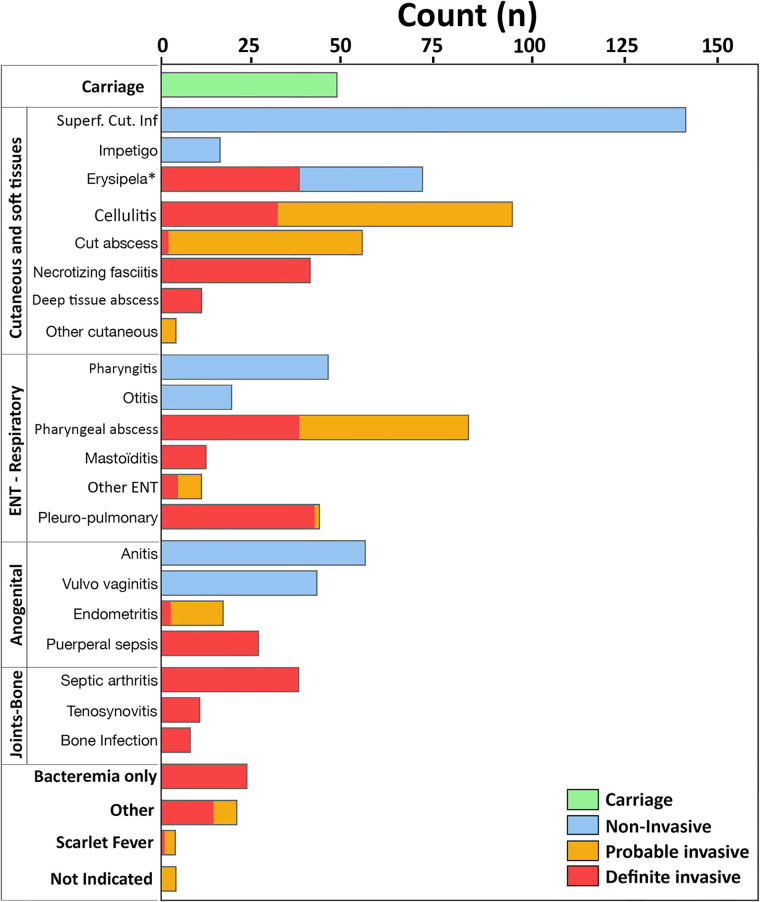
Clinical diagnosis of GAS infections.Infection diagnoses were organised according to their main location. For each diagnosis, invasiveness categories (“Carriage”, “Non-invasive”, “Probable invasive”, and “Definite invasive”) were indicated by colours (see the legend at the bottom right). *Cases reported as erysipelas were considered as definite invasive infections when blood cultures were positive. The clinical presentations identified as “Other cutaneous” included chronic eschars (n = 3) and cutaneous fistula (n = 1); “Other ENT” included periorbital cellulitis (n = 4), ethmoiditis (n = 2), ocular non-invasive infections (n = 2), pharyngitis with diffuse sinusitis (n = 1), abscess of the nasal septum (n = 1) and peri-tracheal deep infection (n = 1); The group “Other” included peritonitis (n = 4), meningitis/cerebral abscess (n = 3), urinary infection (n = 3), mediastinitis (n = 2), cervical adenitis (n = 1), pacemaker infection (n = 1), pericarditis (n = 1), chorioamnionitis (n = 1) and post-infectious glomerulonephritis (n = 1). For the four patients with unavailable clinical diagnosis, the isolates were collected from a cutaneous specimen. Abbreviations: Cut. abscess = cutaneous abscess; ENT = Ear Nose and Throat; Superf. Cut. Inf = superficial cutaneous infection.